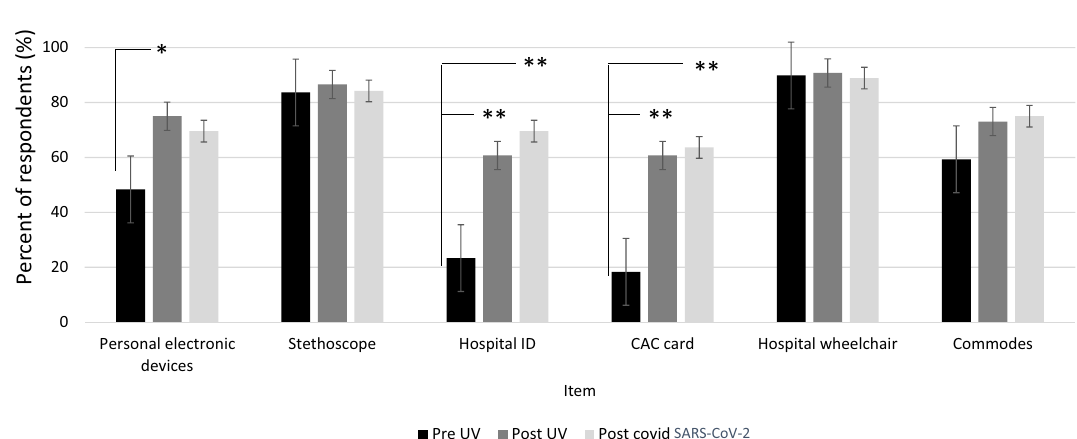
Figure 1. Percentage of nursing staff who performed disinfection of high-touch surfaces at least once daily. Baseline sampling: n =11 for CAC, n =14 for IDs, n =29 for PEDs, and n = 46 for stethoscopes. Post-UV sampling: n =34 for CAC, n =34 for IDs, n =34 for hands, n =42 for PEDs, and n =45 for stethoscopes. All post-SARS-CoV-2 sampling n =16 except for CAC ( n =14) and commodes ( n =12). CleanSlate UV was limited to include only cards, phones, and stethoscopes. Error bars denote Standard Error, ** p ≤0.001; * p ≤0.05.